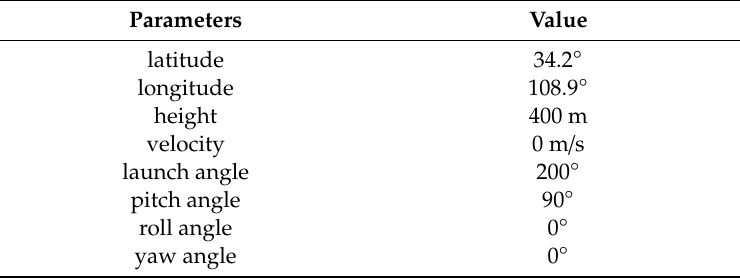
Table 1. The initial state of the trajectory.